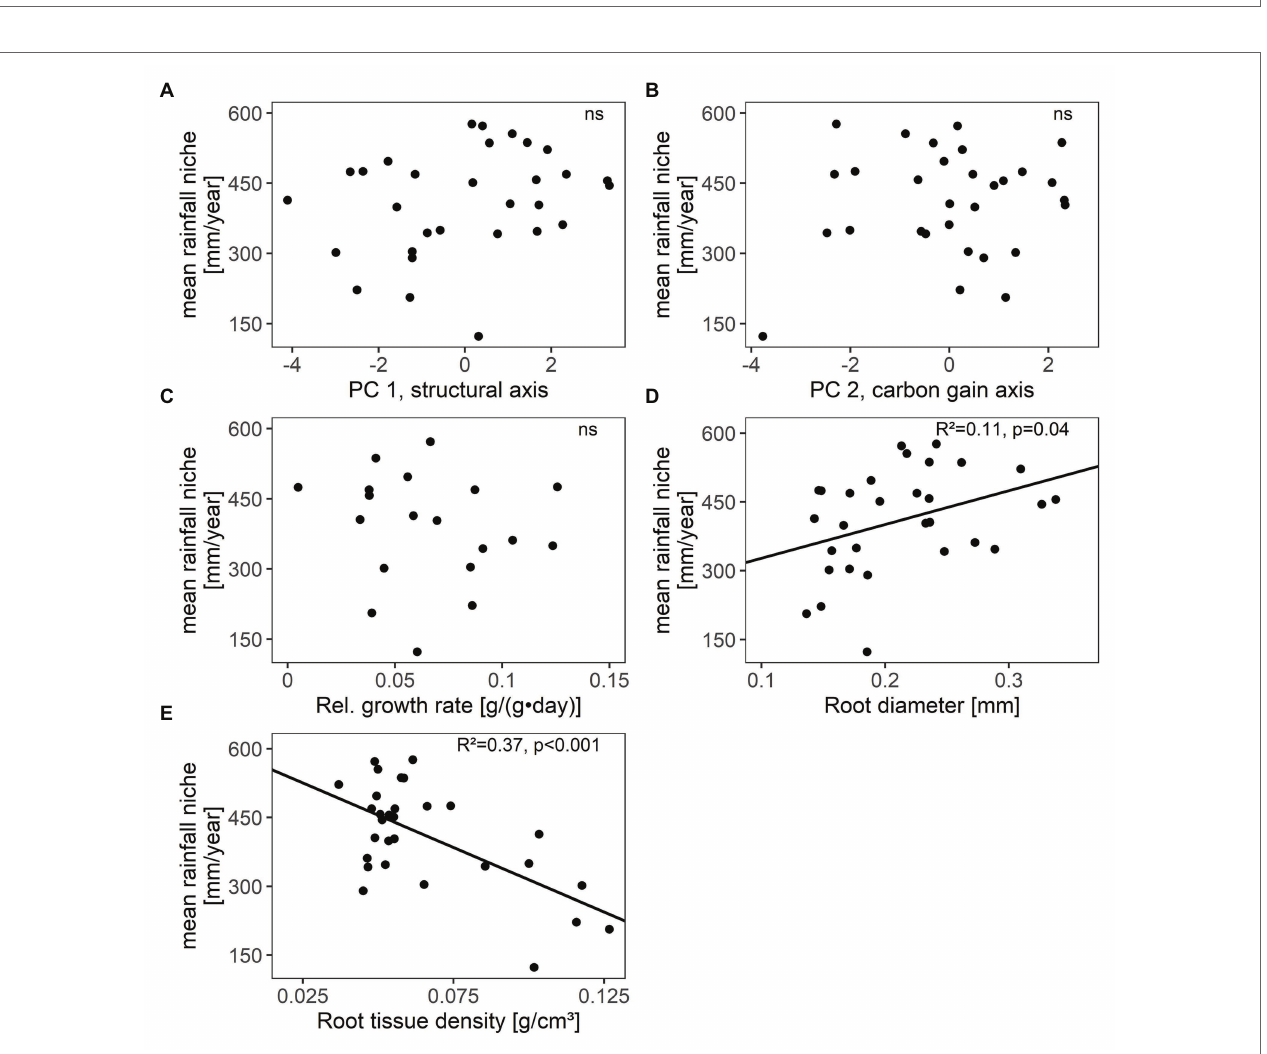
FIGURE 3 | Relations between species’ mean annual rainfall niche (i.e., species’ distribution along the rainfall gradient) and (A,B) their scores along the two main axes of resource-use related traits (PC 1, PC 2), (C) relative growth rate, (D) root diameter, and (E) root tissue density in 30 winter annual species (relative growth rate was only assessed in 19 species). R 2 values and significance were given (ns not significant, for details see Supplementary Table S6 ). Further single traits were unrelated to species’ mean annual rainfall niche (see Supplementary Table S6